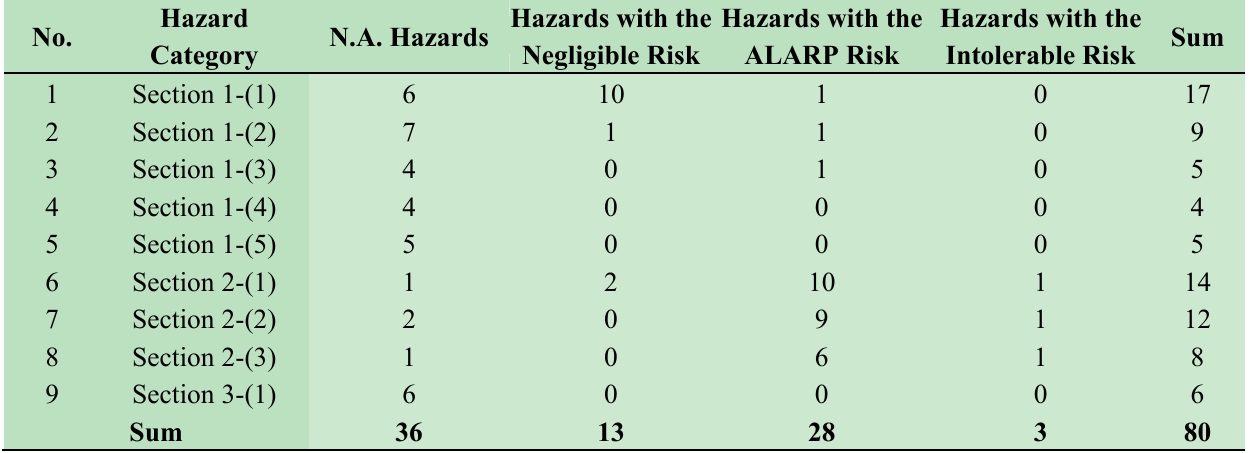
Table 9. Number of hazards by hazards category and risk